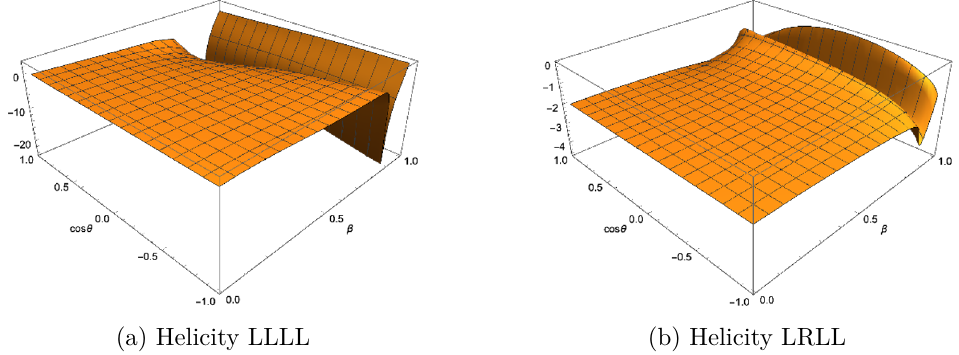
Figure 10. Finite remainder of the vector-vector and axial-axial part of two-loop, sub-leading in colour ( 1 /N C ), helicity amplitudes interfered and normalised by the leading order amplitude, see eq. (5.9). We set the renormalisation scale µ = 2 m W